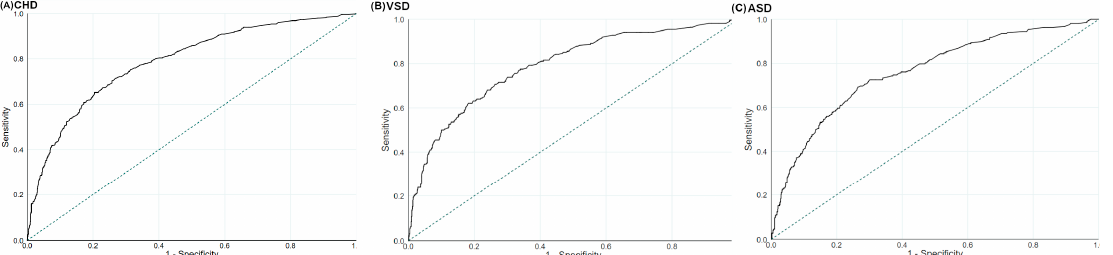
Figure 3. The ROC for the Mediterranean Diet Score during pregnancy in the prediction of (A) total congenital heart defects, (B) ventricular septal defects, and (C) atrial septal defects. ASD, atrial septal defects; CHD, congenital heart defects; ROC, receiver operating characteristic curves; VSD, ventricular septal defects. The dotted line refers to the reference line, resulting from random selection.